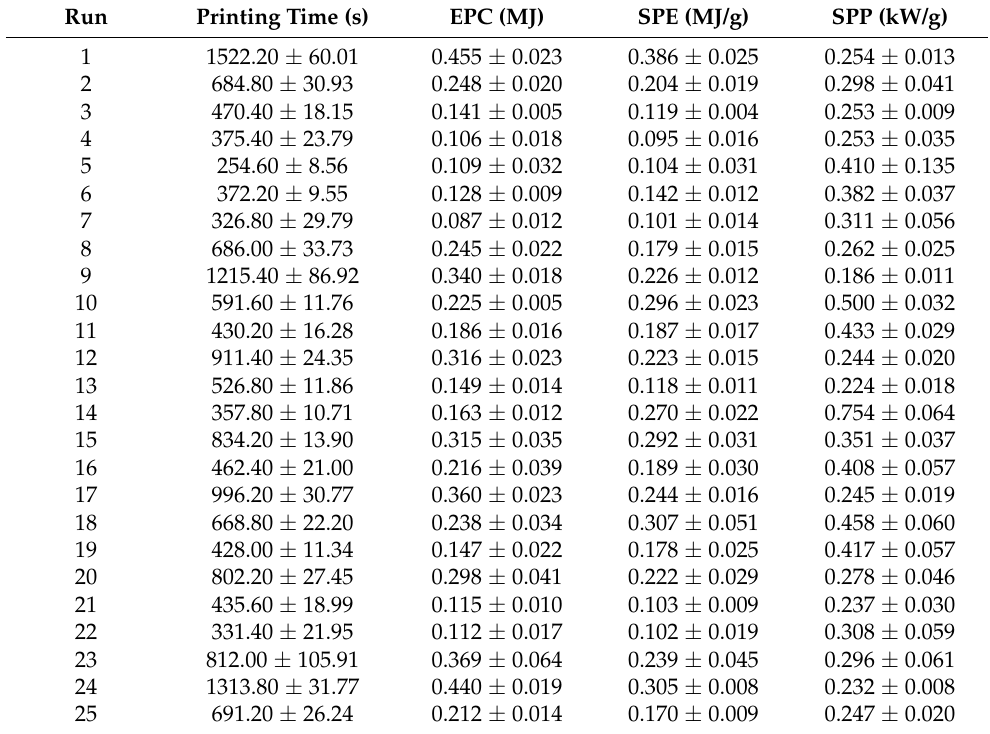
Table 3. Average and standard deviation values of measured responses for printing time, EPC, SPE, and